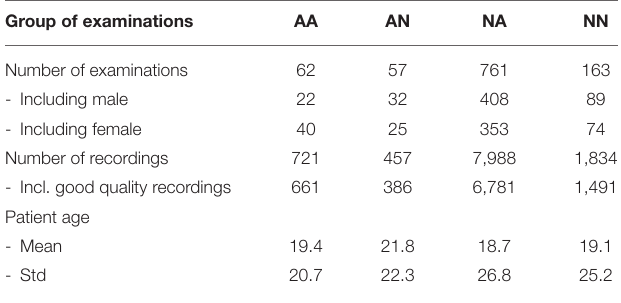
TABLE 2 | Validation dataset.